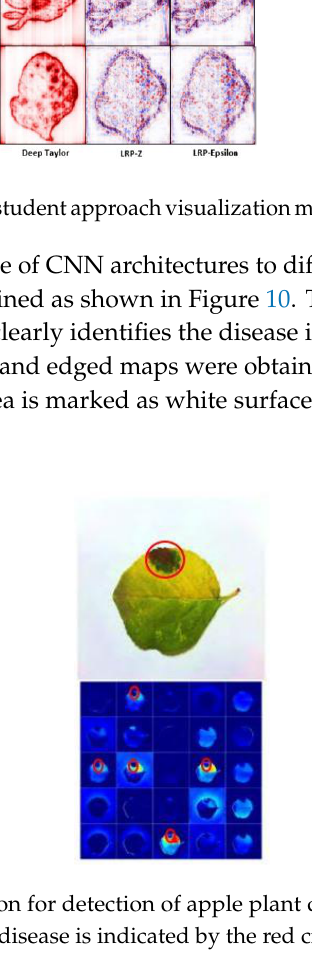
Figure 8. ( a ) Teacher/student architecture approach; ( b ) segmentation using a binary threshold algorithm [67] .